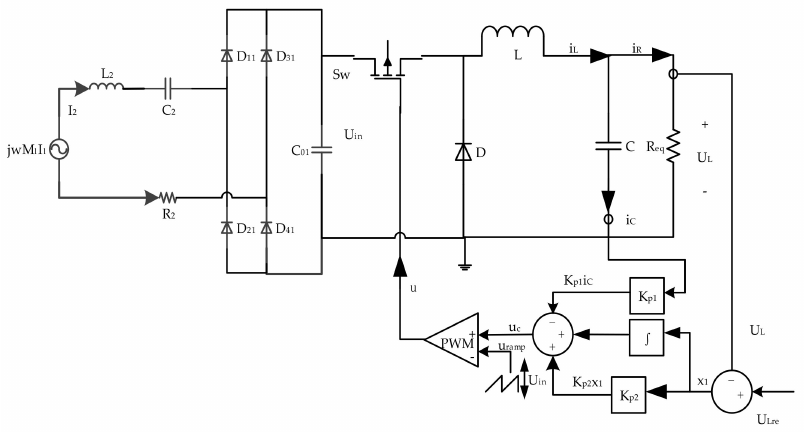
Figure 13. Wireless power transfer (WPT) system circuit diagram of the secondary side Buck converter based on LCC-S